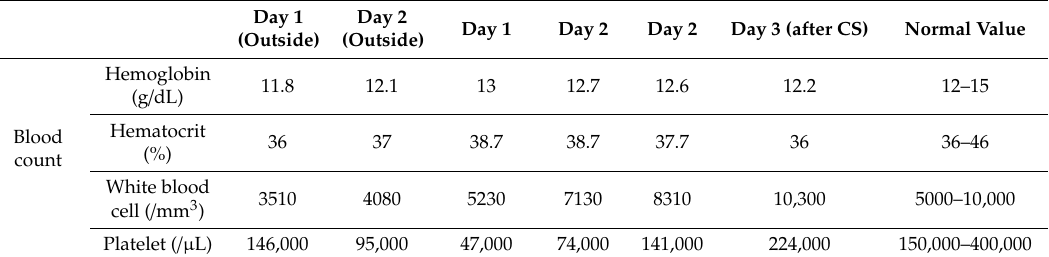
Table 3. Laboratory